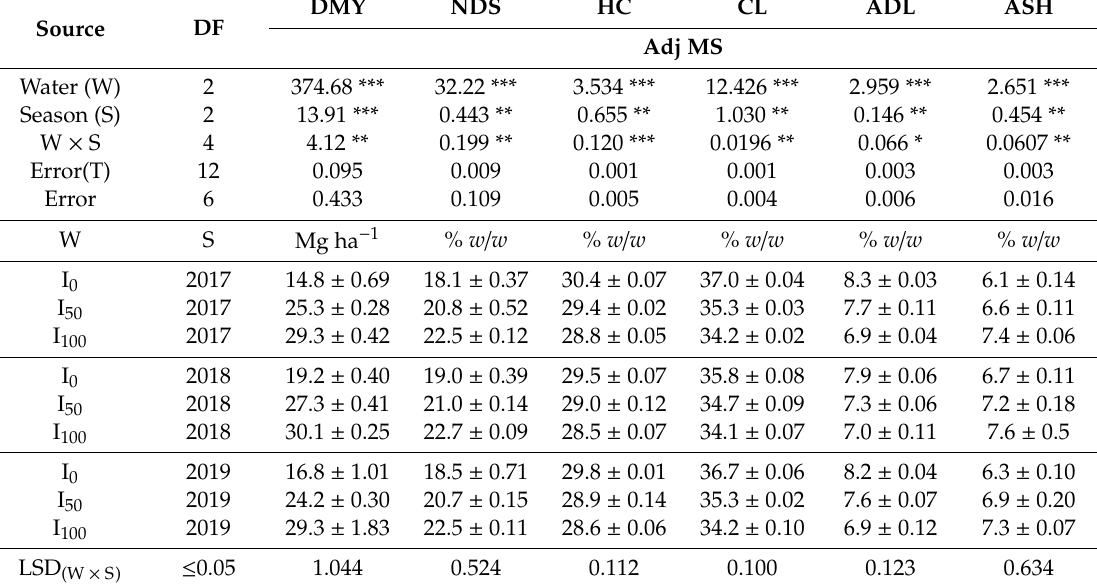
Table 1. Repeated measures analysis of variance (ANOVA) for the main e ff ects and interactions on dry matter yield (DMY), neutral detergent soluble (NDS), hemicellulose (HL), cellulose (CL), acid detergent lignin (ADL), and ash content (ASH) of Saccharum under changing irrigation (W) and growing season (S). Degree of freedom (DF); adjusted mean square (Adj MS); Significance indicated by * at p ≤ 0.05, ** at p ≤ 0.01, *** at p ≤ 0.001. LSD value indicates a significant “water × growing season” interaction at p ≤